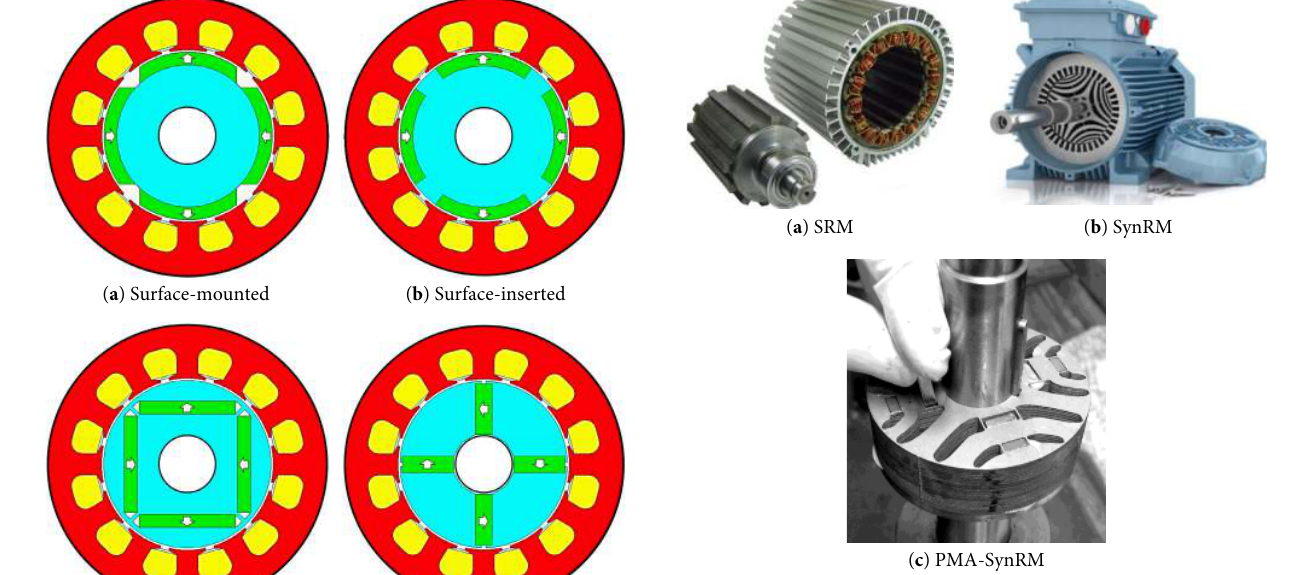
Fig. 12 Different types of